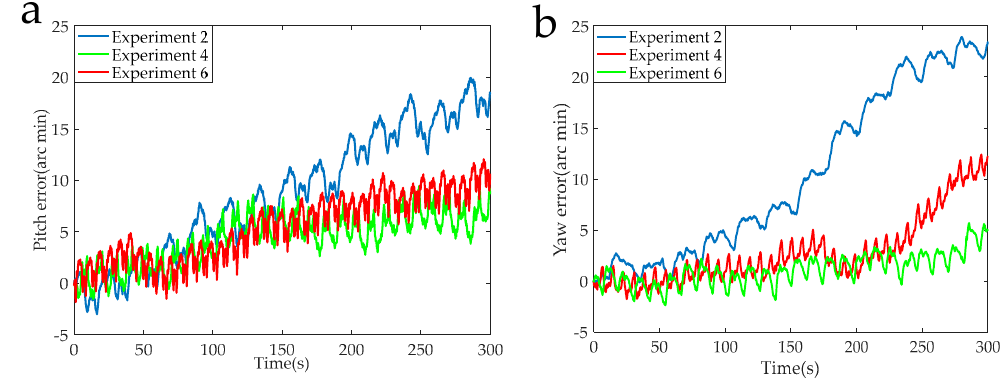
Figure 14. ( a ) Pitch error curves of the Experiments 2, 4, and 6. ( b ) Yaw error curves of the Experiments 2, 4, and 6.